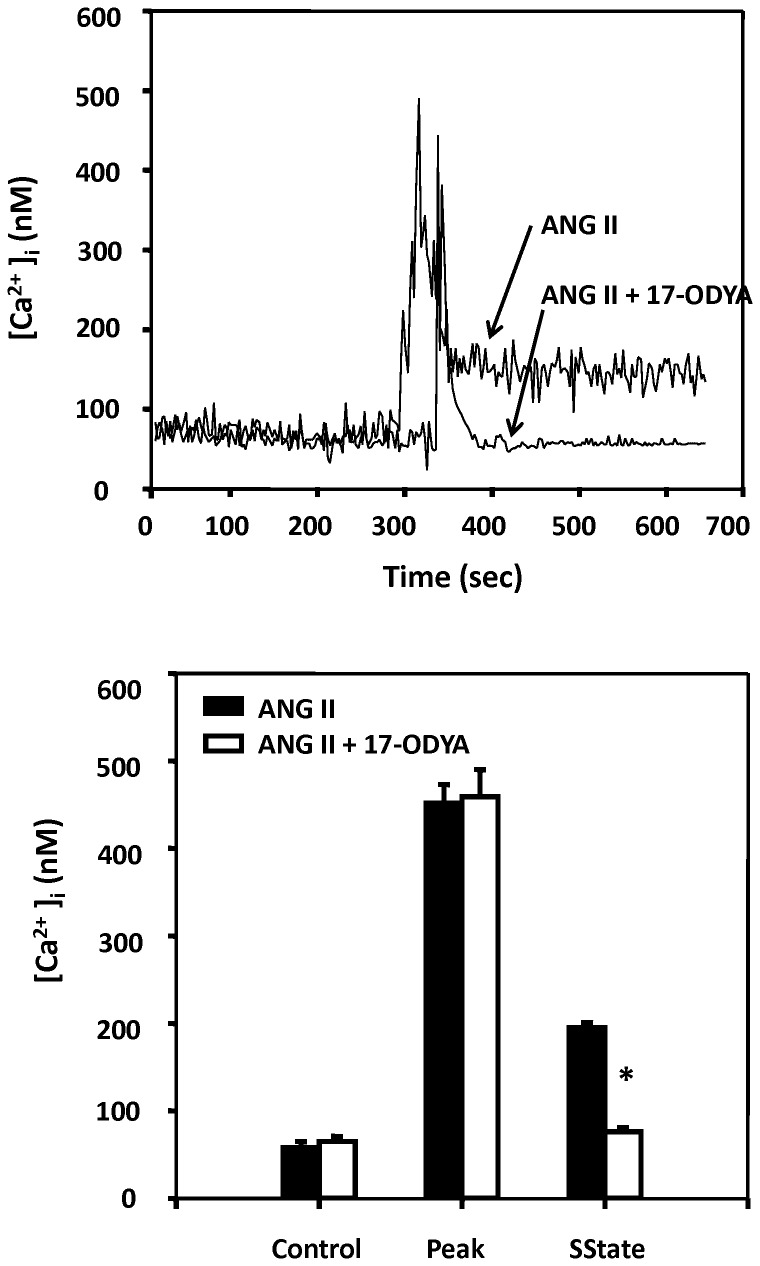
Effects of ANG II on [Ca2+]i in renal VSM cells before and after 17-ODYA.The upper panel presents representative tracings of the effect of ANG II on [Ca2+]i in renal VSM before and after blockade of the synthesis of 20-HETE with 17-ODYA (10-5 M). The lower panel presents the peak and steady state [Ca2+]i responses to ANG II measured before and after addition of 17-ODYA to the bath. Mean values + SE recorded from 25-30 cells (5-8 cells per experiment) isolated from 6 different renal VSM isolations are presented. * indicates a significant difference between ANG II and ANG II plus 17-ODYA treated vessels.